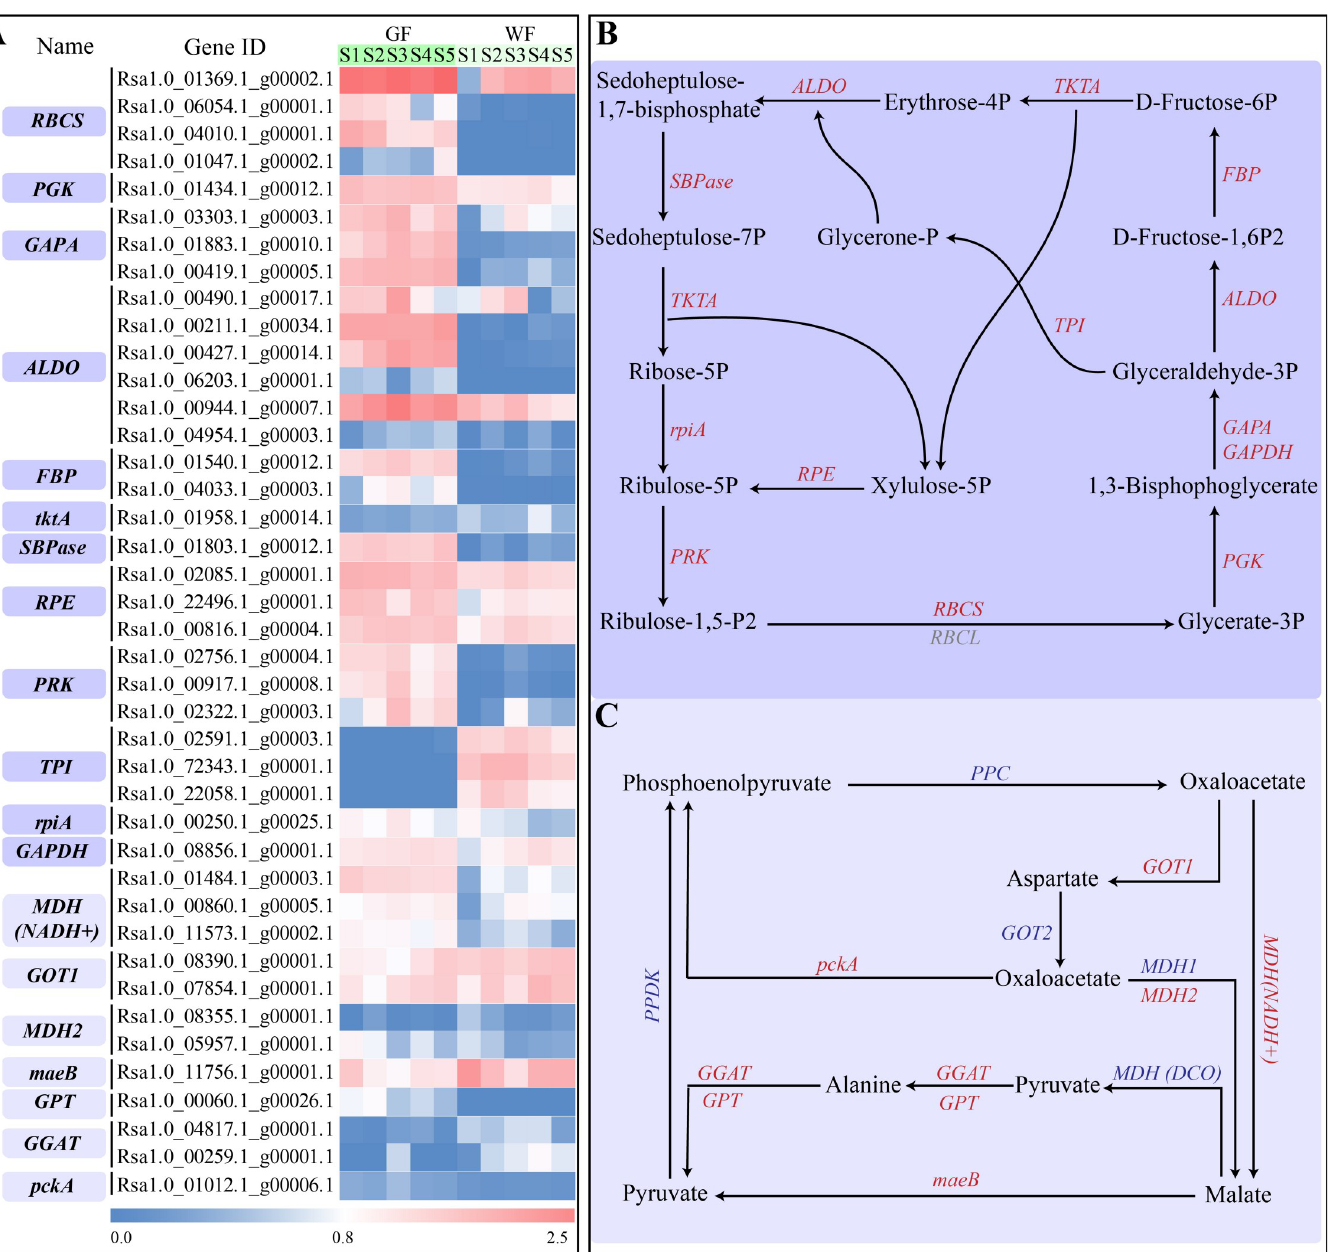
Fig 8. Carbon fixation pathway and expressions of genes involved in carbon fixation. A , A heatmap of the expressions of carbon fixation DEGs in GF and WF radish taproot flesh at five developmental stages. B , The Calvin cycle. C , The C 4 -Dicarboxylic acid cycle. RBCS, ribulose-bisphosphate carboxylase small chain; RBCL, ribulose- bisphosphate carboxylase large chain; PGK, phosphoglycerate kinase; GAPA, glyceraldehyde-3-phosphate dehydrogenase; ALDO, fructose-bisphosphate aldolase; FBP, fructose-1,6-bisphosphatase I; tktA, transketolase; SBPase, sedoheptu-lose-bisphosphatase; RPE, ribulose-phosphate 3-epimerase; PRK, phosphoribulokinase; TPI, triosephosphate isomerase; GAPDH, glyceraldehyde 3-phosphate dehydrogenase; rpiA, ribose 5-phosphate isomerase A; MDH1, malate dehydro-genase 1; MDH (NADH +), malate dehydrogenase (NADH+); GOT1, aspartate aminotransferase; MDH2, malate dehy-drogenase 2; maeB, malate dehydrogenase; GPT, alanine transaminase; GGAT, glutamate-glyoxylate aminotransferase; pckA, phosphoenolpyruvate carboxykinase (ATP); ppDK, pyruvate, orthophosphate dikinase; PEPC, phosphoenolpy- ruvate carboxylase; GOT2, aspartate aminotransferase, mitochondrial; MDH (DCO), malate dehydrogenase (decarboxylating). Genes showing significant differential expression in at least one stage are indicated in red; Genes showing no significant differential expression are indicated in blue; Genes that were not detected in this study are indicated in grey.